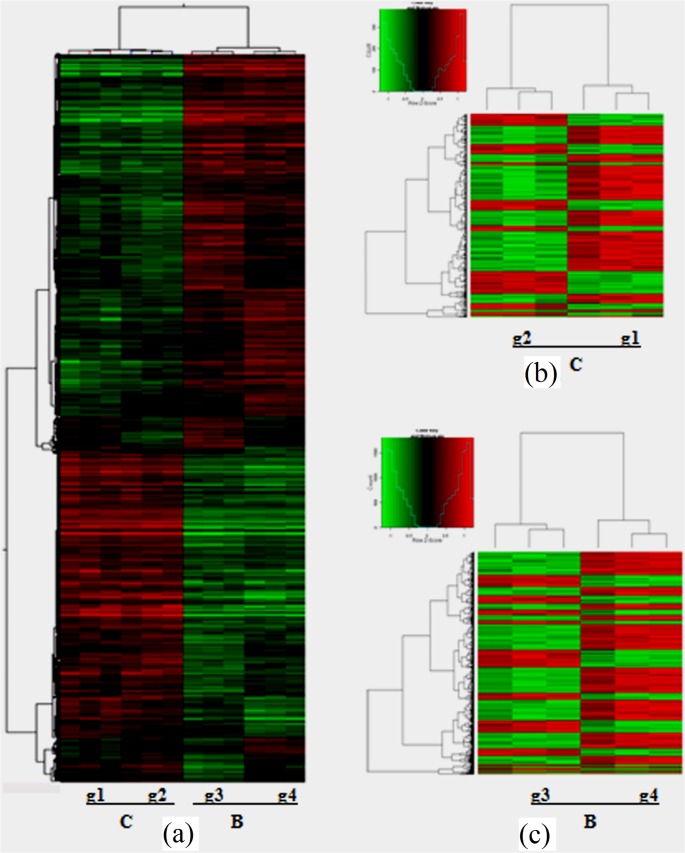
Cluster analysis for DEGs.(a) Cluster analysis for g1, g2, g3 and g4 (p<0.01, top 5,000); (b) Cluster analysis for g1 and g2 (p<0.01); (c) Cluster analysis for g3 and g4 (p<0.01).